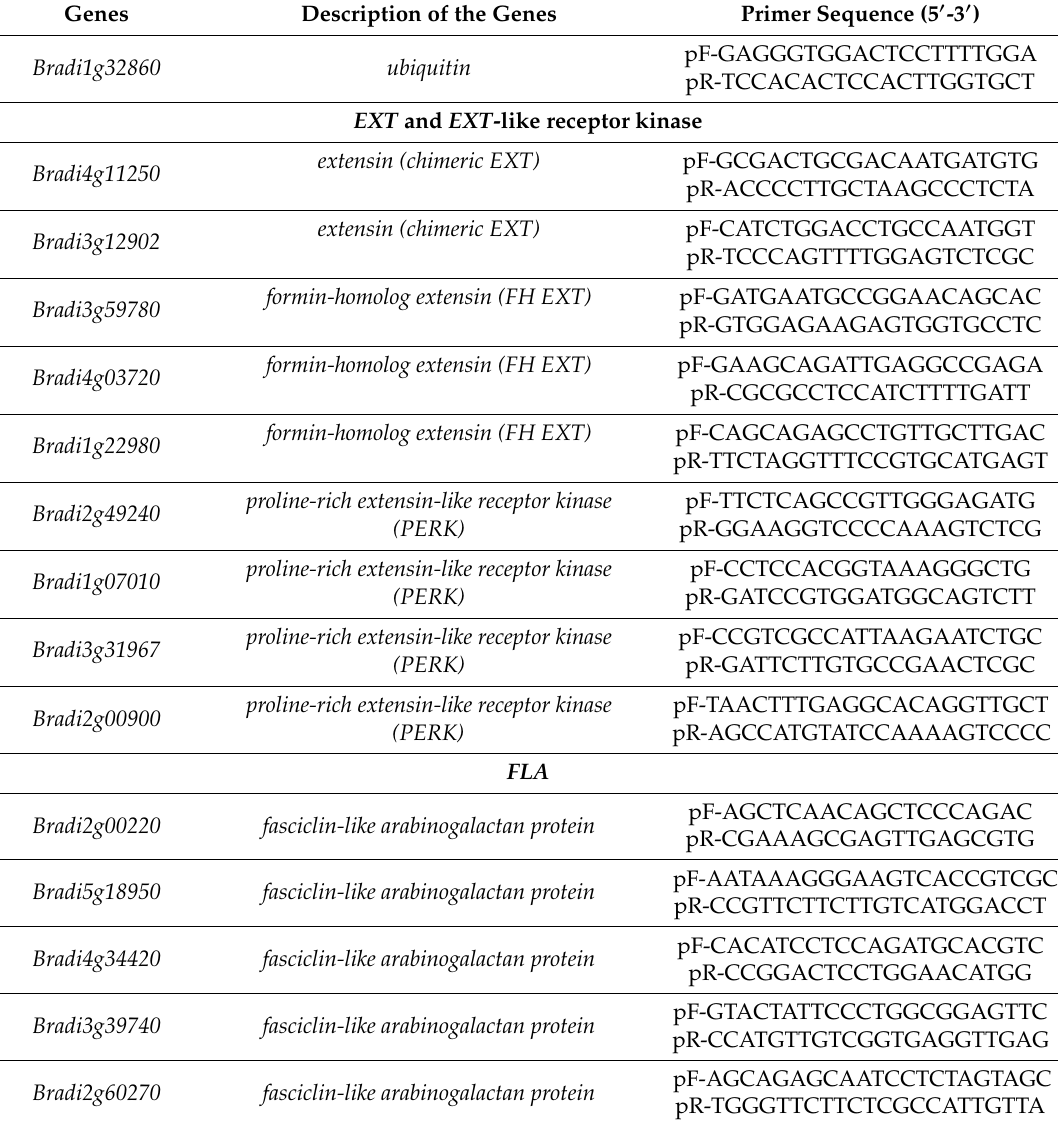
Table A1. The oligonucleotide primers that were used for the RT-qPCR reaction with relevant descriptions of the